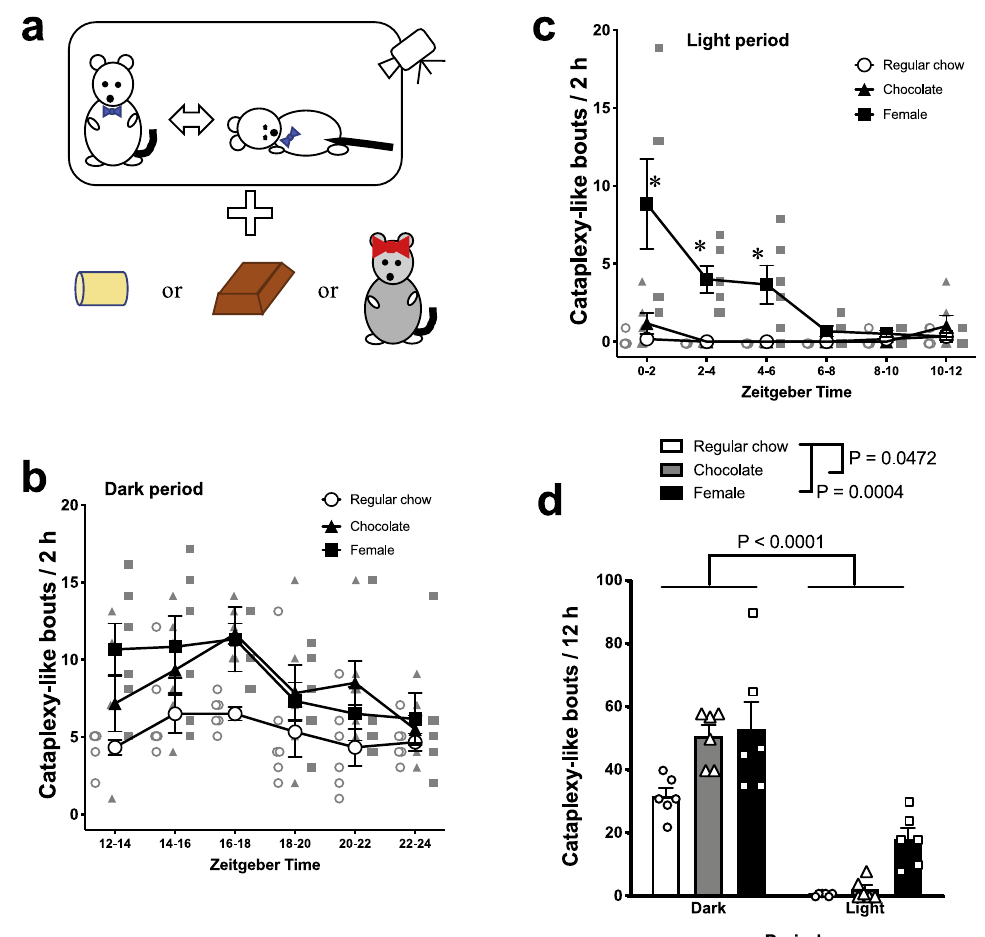
Fig. 1 Time-dependent occurrence of cataplexy-like behavior and the effect of chocolate and female encounter. a Schematic explanation of the experiment. Behavior of orexin neuron-ablated male mouse was video observed with regular chow, chocolate, or female for 12 h. b The number of cataplexy-like bouts during the dark period (ZT12 – ZT24) in three treatment groups. Two-way ANOVA (treatment: regular chow, chocolate, female × period: bin length of 2 h) revealed that there was a signi fi cant difference in the number of cataplexy-like bouts during the dark period among treatments ( F 2,15 = 4.094, P = 0.0381) and between time points ( F 5,75 = 5.723, P = 0.0002). The interaction was not signi fi cant ( F 10,75 = 1.148, P = 0.3395). c The number of cataplexy-like bouts during the light period (ZT0 – ZT12) in three treatment groups. There was a signi fi cant difference among treatments ( F 2,15 = 20.85, P < 0.0001) and between time points ( F 5,75 = 6.639, P < 0.0001). The interaction was also signi fi cant ( F 10,75 = 5.368, P < 0.0001). d Summary for light/dark period over 12 h. Overall, the number of cataplexy-like bouts was higher during the dark period than during the light period ( F 1,15 = 99.19, P < 0.0001). Note that both chocolate and female encounter increased the number of cataplexy-like bouts during the dark period compared to regular chow. Only female encounter increased the number of cataplexy-like bouts during the light period. The effect of the female encounter on number of cataplexy-like bouts was short-lived and gradually decreased toward regular chow level over 6 h. Data are expressed as mean ± SEM. n = 6 for each group. * P < 0.05 as compared to regular